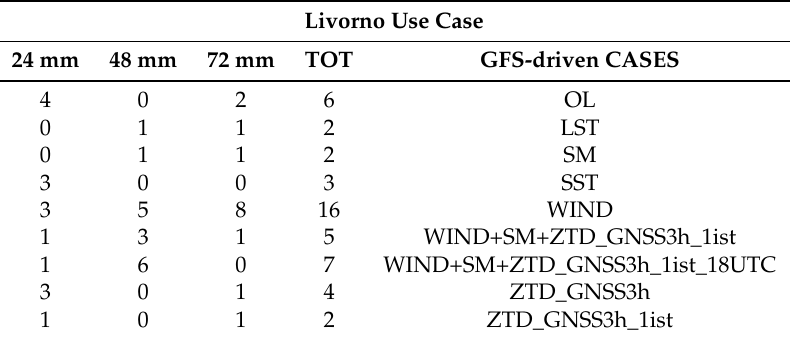
Table A6. Summary of the sensitivity performances (IFS-driven cases). The times in which each forecast has the best result for each score is counted for each threshold and summarized in a total count (summing Tables A2–A4) that is used to find the best